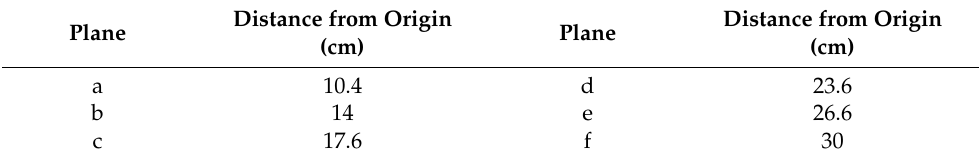
Table 3. The z location from the origin for